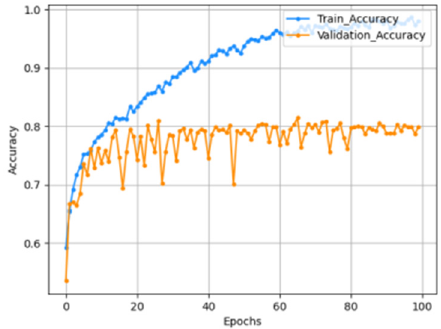
Figure 8. Loss graph.